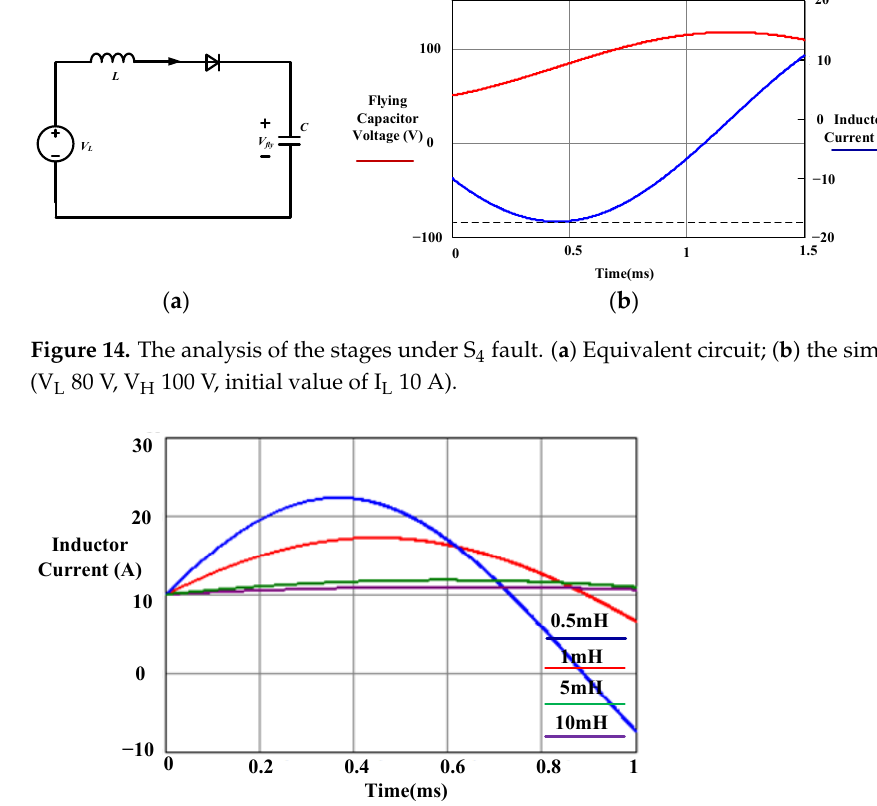
Figure 15. Maximum current under different levels of inductance when S 4 is short-circuited. The parameters of the flying capacitor DC/DC converter can be calculated as